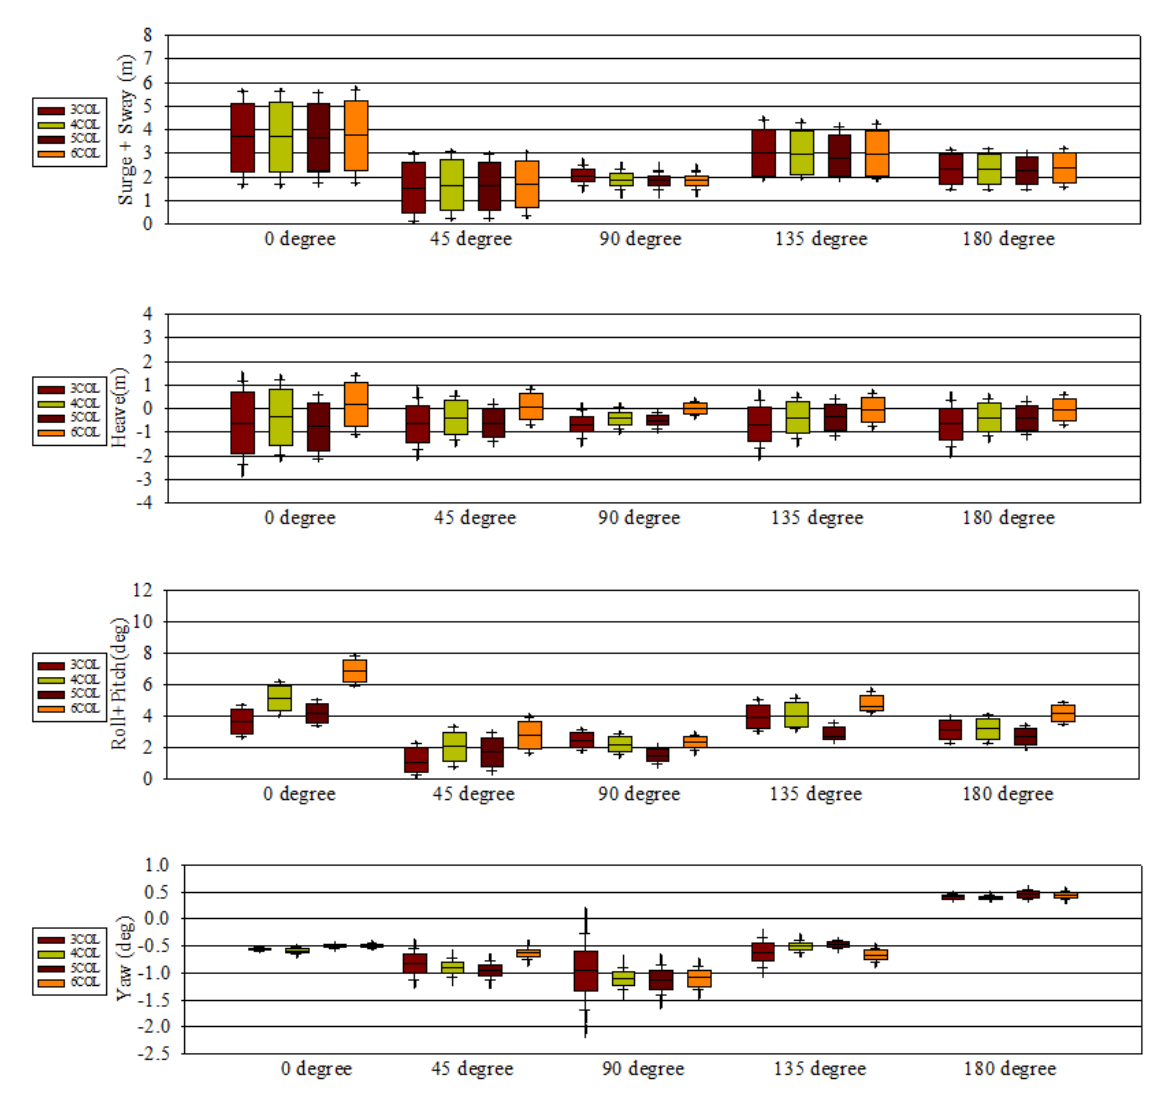
Figure 22. Misalignment case stability analysis results using fully ‐ coupled simulation.